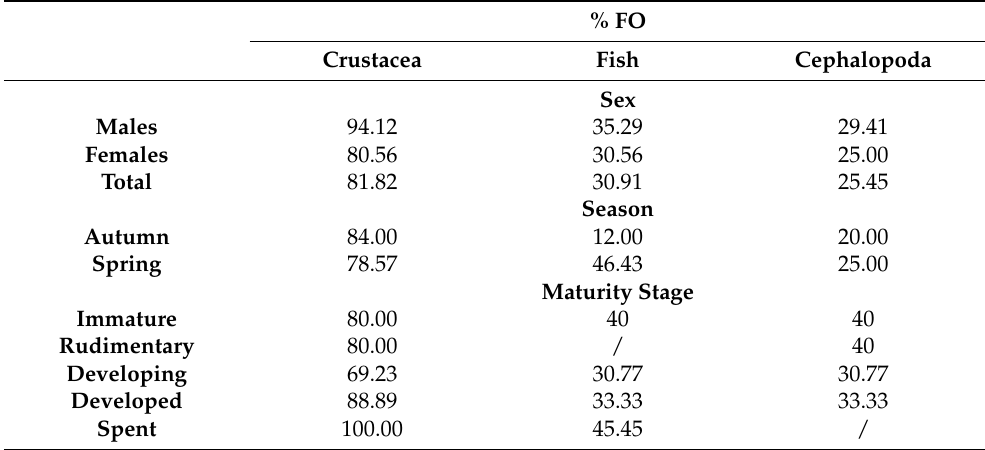
Figure 7. Histological cross sections of Calappa granulata ovary: ( A ) Developed ovary showing vitellogenic oocytes (vo), with oval nucleus (n) and distinct peripheral nucleolus (nc), surrounded by a thick layer of connective tissue (ct); ( B ) ovarian section through central germinative zone filled with oogonia (og), previtellogenic oocytes (pvo) and vitellogenic oocytes (vo).; ( C ) detail of ovary with oogonia (og) and previtellogenic oocyte (pvo); ( D ) mature oocyte surrounded by a thin layer of follicular cells (fc), showing numerous yolk granules (yg) and lipid droplets (ld) with nucleus (n) barely visible. Table 5. Percentage frequency of prey occurrence (% FO) from stomach contents of Calappa granulata from the central eastern Adriatic